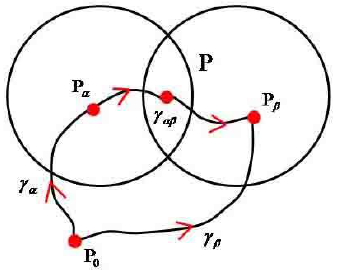
Figure 10. Construct a vector bundle.